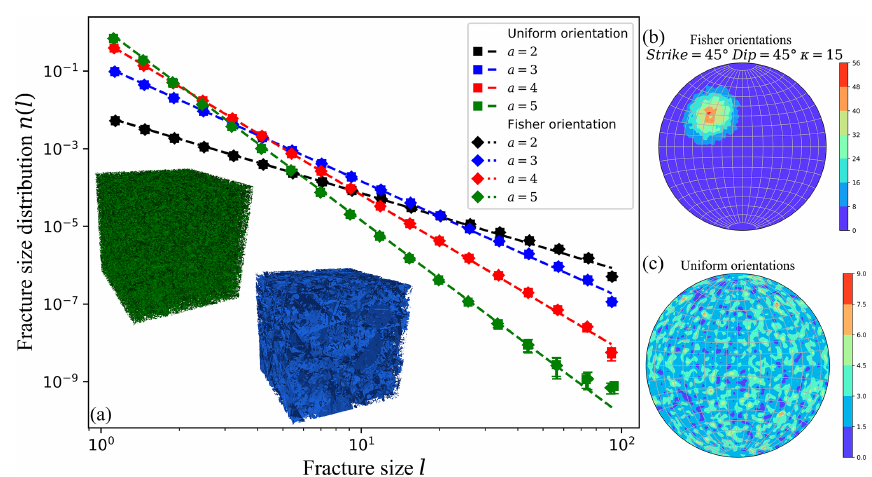
Figure 1. (a) Fracture size distribution of generated networks sets (3–6) following power-law size distribution with a bulk density p 32 = 0 . 5 and different power-law exponent a indicated in the legend box ( a = 3 in blue, a = 5 in green), and (b) – (c) stereonets for the two defined orientation distributions.